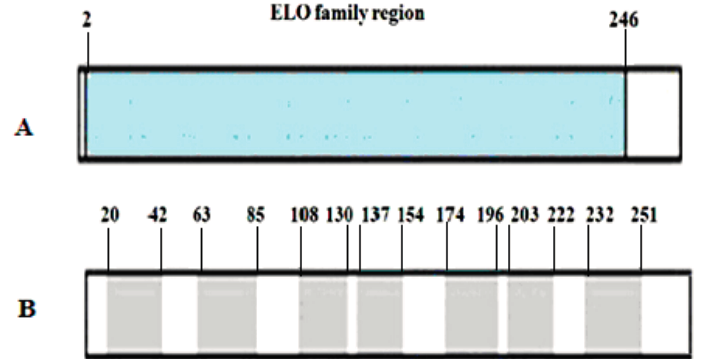
Figure 3. Predicted domains of goat ELOVL1. ( A ) ELO family region predicted by Pfam from amino acid residues 2–246; ( B ) Seven transmembrane regions from amino acid residues 20 to 42, 63 to 85, 108 to 130, 137 to 154, 174 to 196, 203 to 222, and 232 to